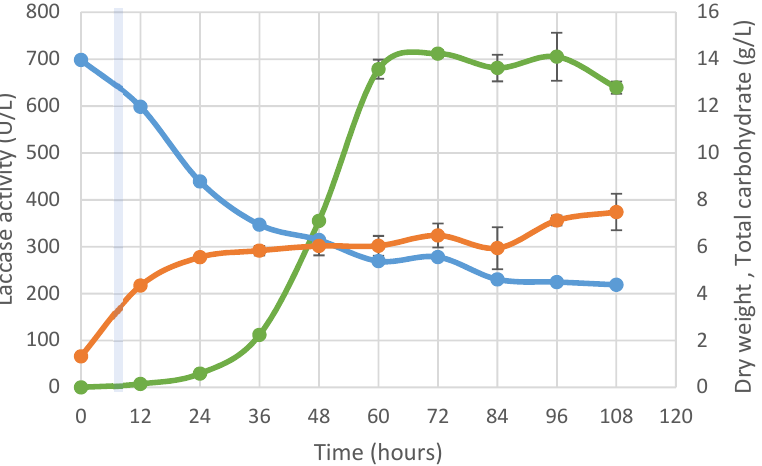
Figure 4. Time course of dry weight (orange), total carbohydrate (blue) and laccase activity (green) during continuous cultivation of P. neostrigosus I9 in tomato juice medium at a dilution rate of 0.05 h − 1 .